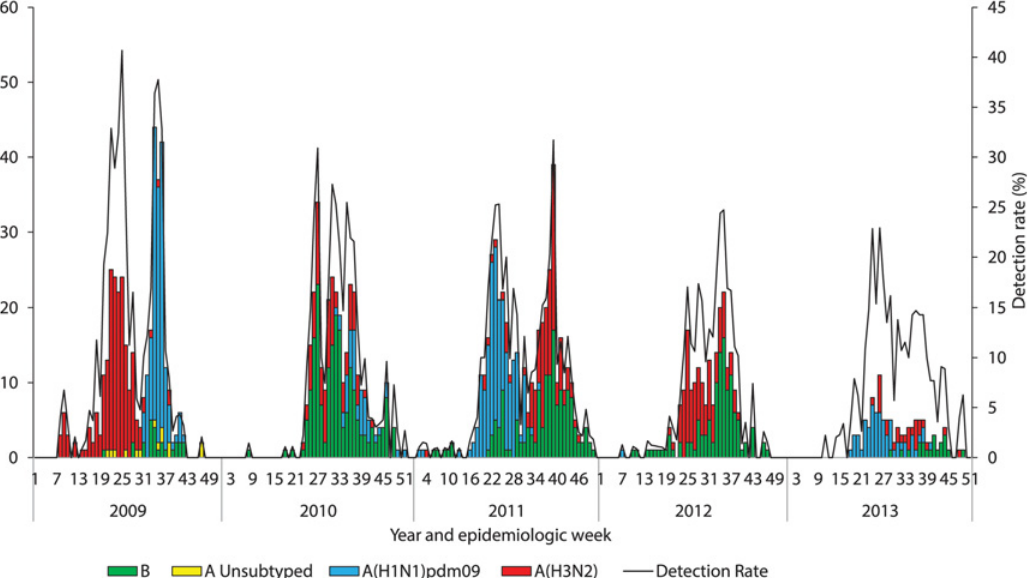
Fig 2. Number of patients testing influenza positive by subtype and influenza detection rate by epidemiologic week and year among patients hospitalized with severe acute respiratory illness at four sentinel surveillance sites, South Africa, 2009 –